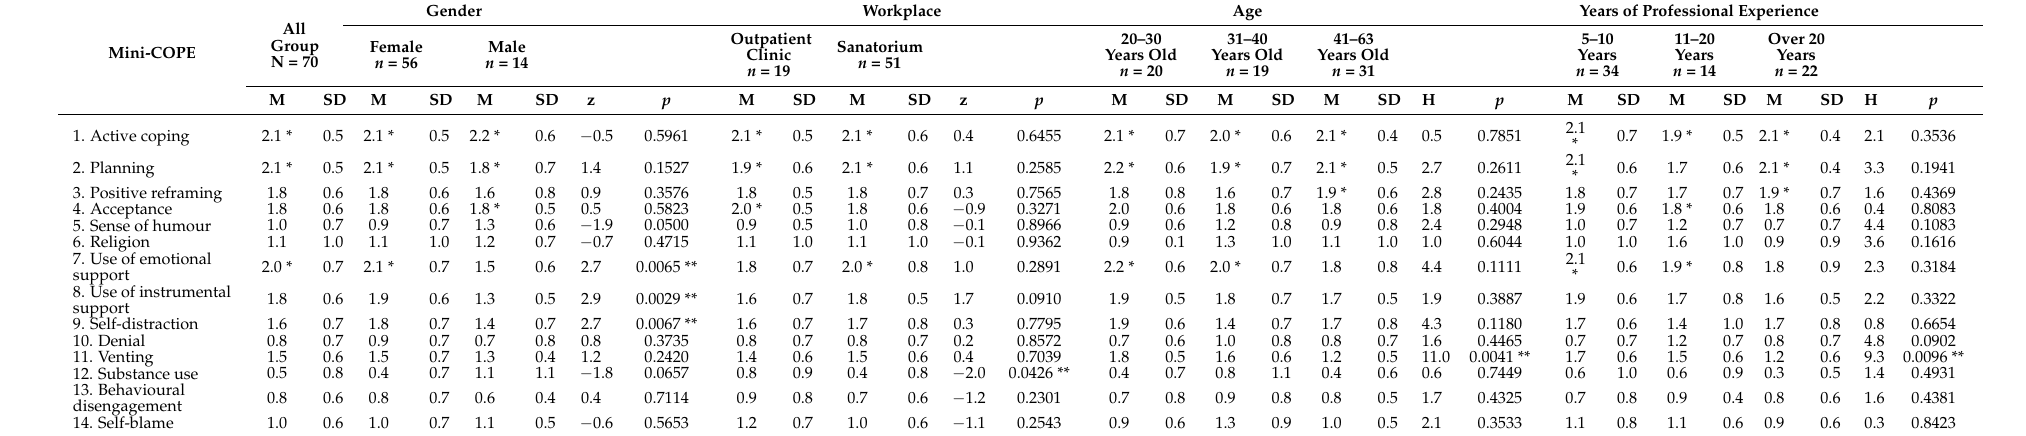
Table 5. The Mini-COPE results in the all study group and in selected subgroups (the Mann–Whitney U test and the Kruskal–Wallis test).